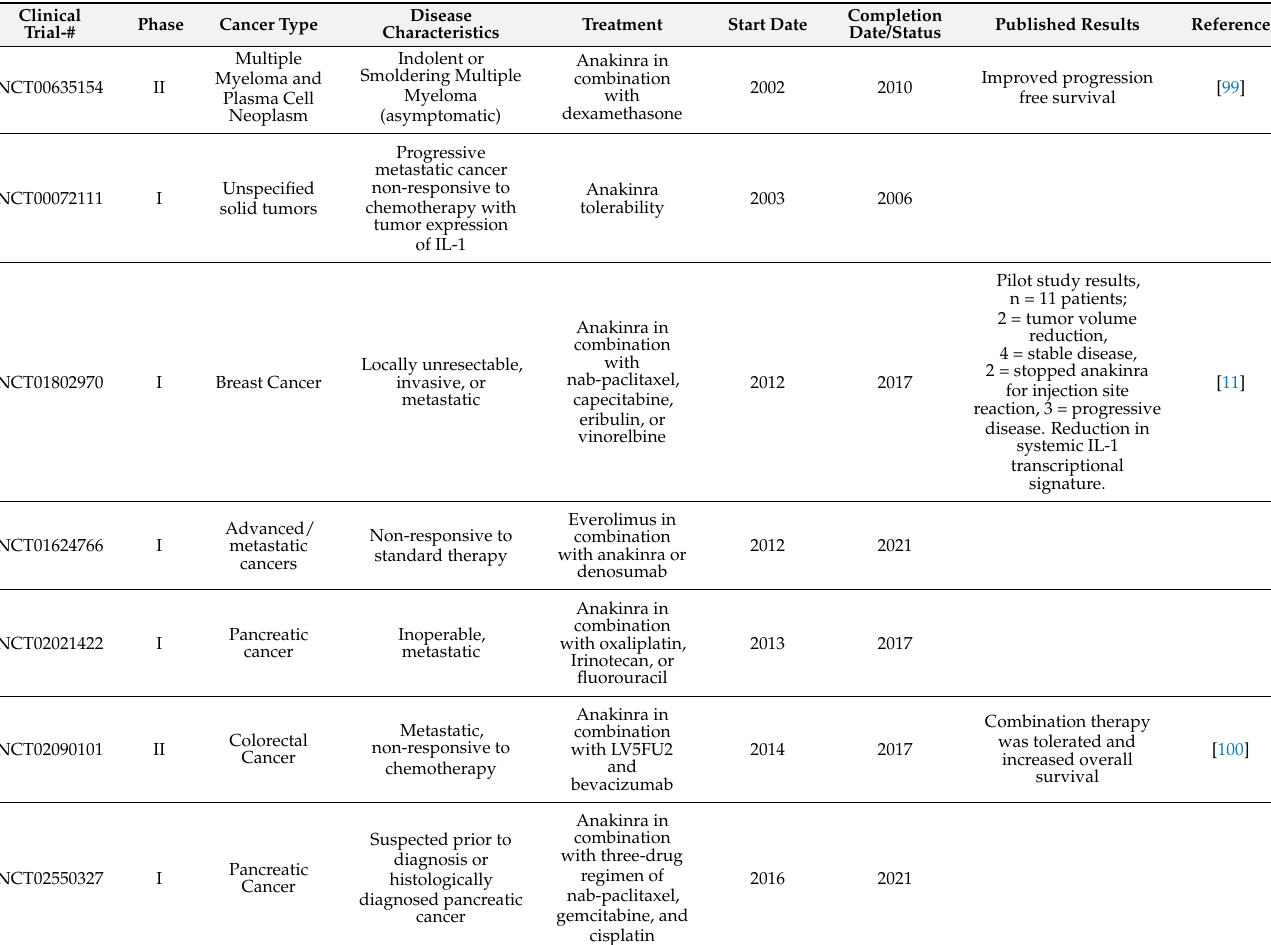
Table 1. Anakinra cancer clinical